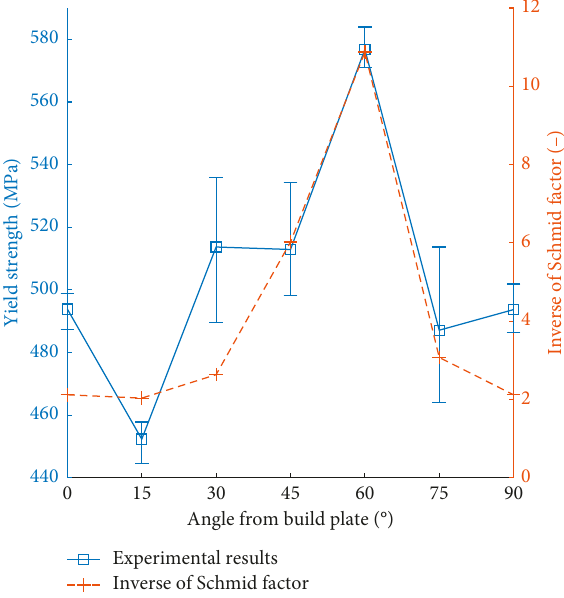
Figure 17: Yield stress for set 1 compared with the inverse Schmid factor for set